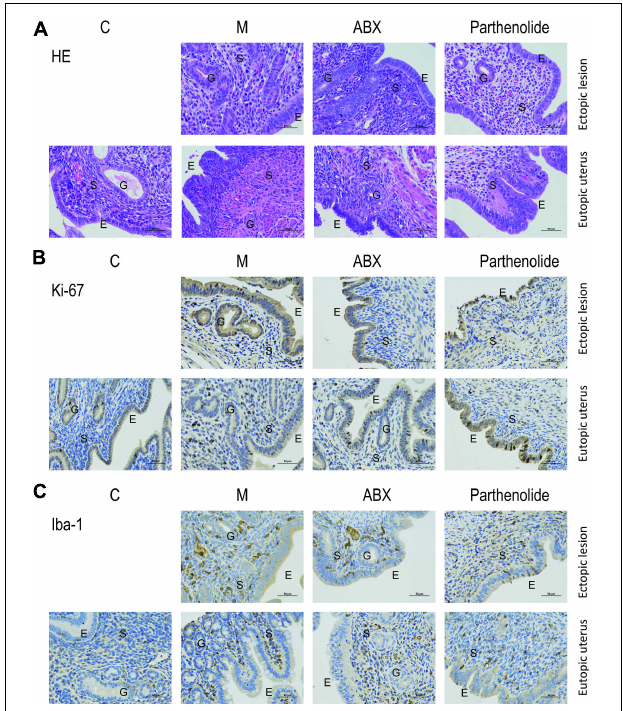
FIGURE 3 | Removing vaginal microorganisms reduces endometriotic lesion progression confirmed by pathological examination. (A) Representative hematoxylin and eosin-stained cross-section images of the eutopic uteri and ectopic lesions from the indicated treatment groups. The scale bar (0.5 µ m) applies to all images. (B,C) Representative cross-sectional images of the eutopic uteri and ectopic lesions immunohistochemistry stained for Ki-67 (B) and Iba1 (C)